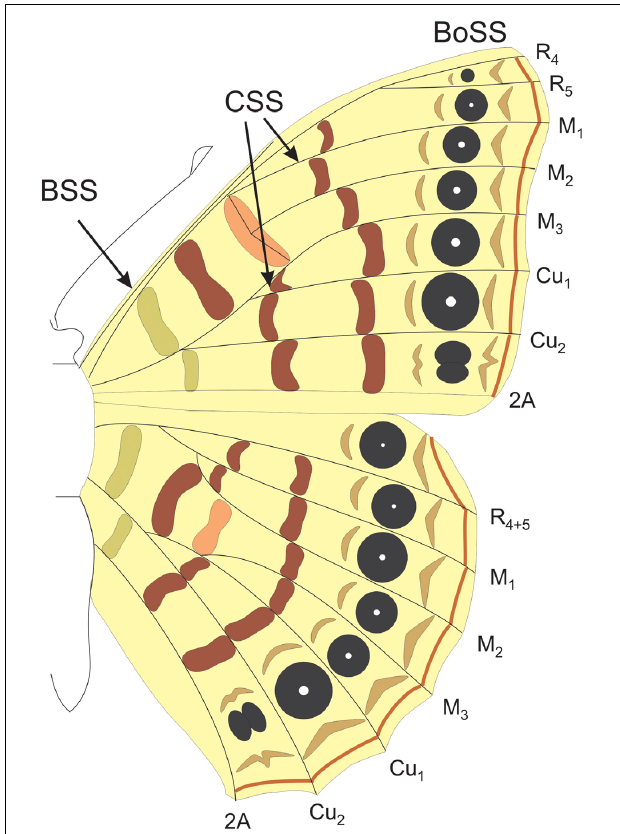
FIGURE 1 | The Nymphalid groundplan. The border symmetry system (BoSS) which includes the border ocelli and parafocal elements. The central symmetry system (CSS) and the basal symmetry system (BSS). Each system is composed of pattern elements that are serially repeated between the wing veins along the anterior–posterior axis of the